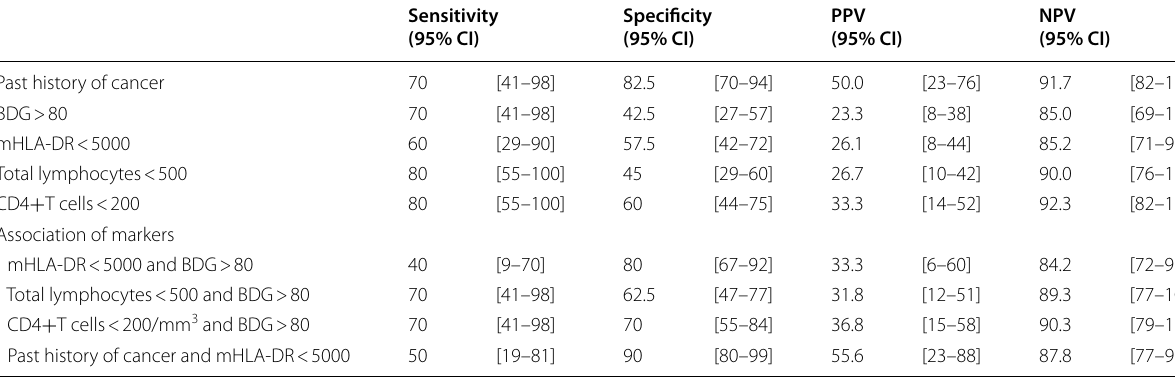
mHLA-DR: monocyte human leukocyte antigen-DR (AB/c); BDG: β-d-glucan (pg/mL); PPV: positive predictive value; NVP: negative predictive value. Lymphocytes, CD4 T cell, CD8 T cell (/mm 3 + +